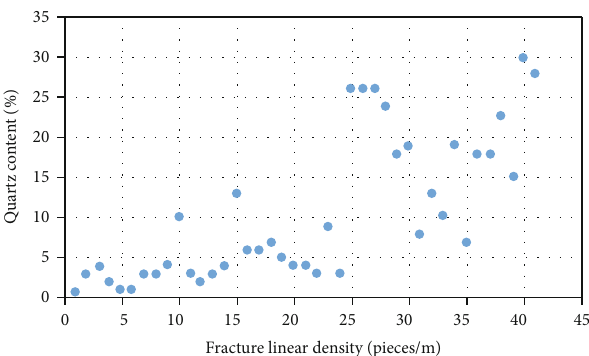
Figure 8: Relationship between shale fracture development and quartz content in Well Yucan-8 of the Longmaxi Formation in southeastern